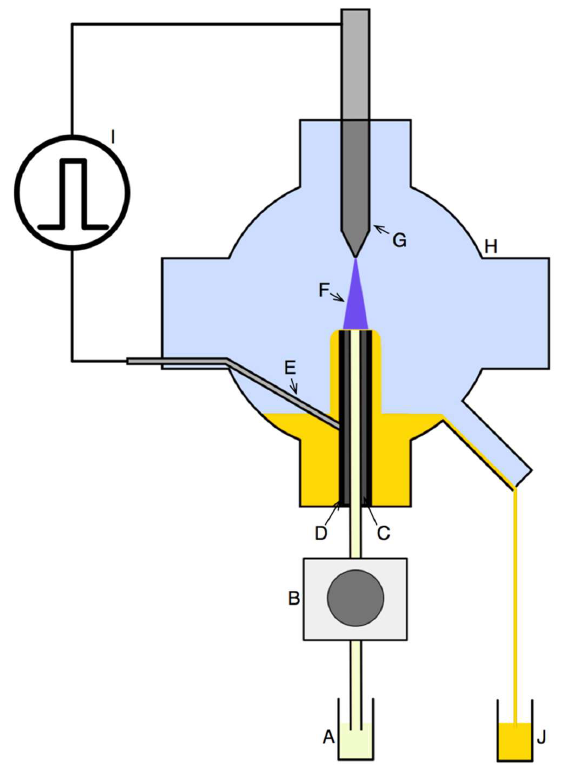
Figure 1. The scheme of the pulse-modulated radio-frequency atmospheric-pressure glow discharge (pm-rf-APGD)-based plasma-reaction system for the continuous production of silver nanoparticles (AgNPs). (A) Solution containing the AgNP precursor with or without pectin; (B) peristaltic pump; (C) quartz capillary; (D) graphite tube; (E) platinum wire; (F) pm-rf-APGD; (G) pin-type electrode; (H) quartz chamber; (I) radio-frequency (rf) voltage; (J) solution after pm-rf-APGD treatment containing AgNPs.